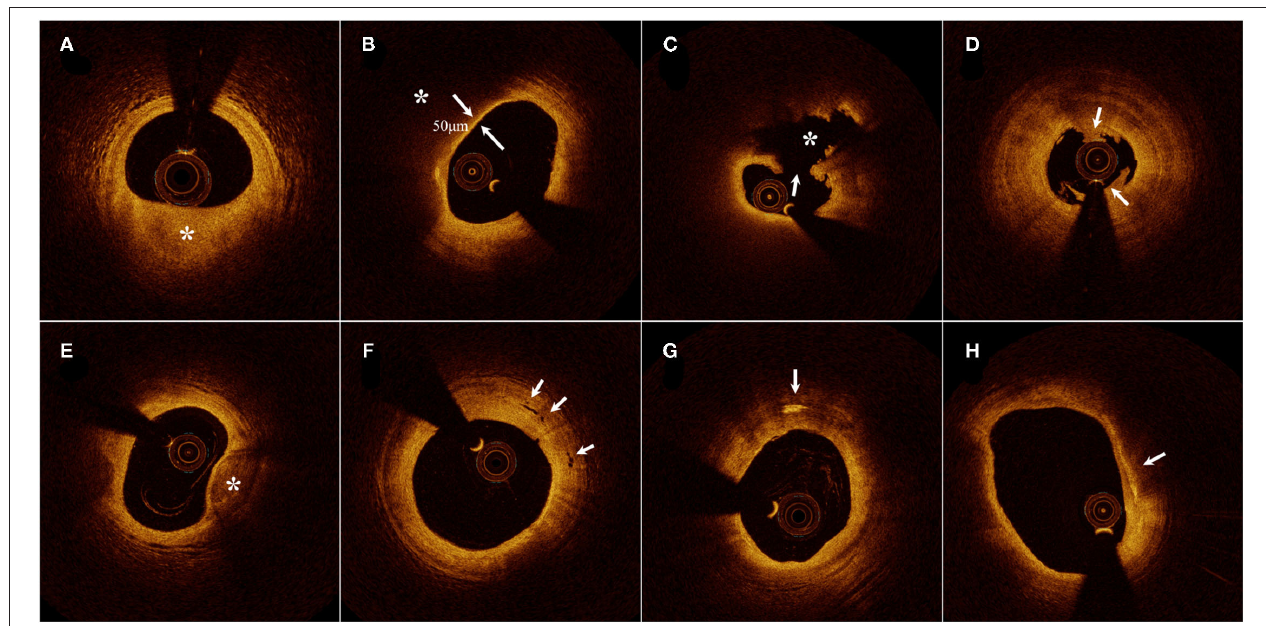
FIGURE 1 | Representative cross-sectional optical coherence tomography images. (A) Fibrous plaque identified as a homogeneous, highly backscattering region (asterisk). (B) Lipid-rich plaque identified as a low-signal region with a diffuse border (asterisk) and thin-cap fibroatheroma with fibrous-cap thickness of 50 µ m. (C) Plaque rupture identified by the discontinuous fibrous cap (arrow) and cavity formation (asterisk). (D) Plaque erosion identified by the presence of attached thrombus (arrow) overlying an intact plaque. (E) Calcification identified by the presence of a well-delineated, low-backscattering heterogeneous region (asterisk). (F) Microvessels recognized as low-signal, sharply delineated, and tubule luminal structures (arrow). (G) Cholesterol crystal (arrow) identified by linear, highly backscattering structures without remarkable backward shadowing. (H) Macrophage infiltration (arrow) defined as a signal-rich, highly reflective, and punctate region with backward shadowing [Adapted from reference (15) with